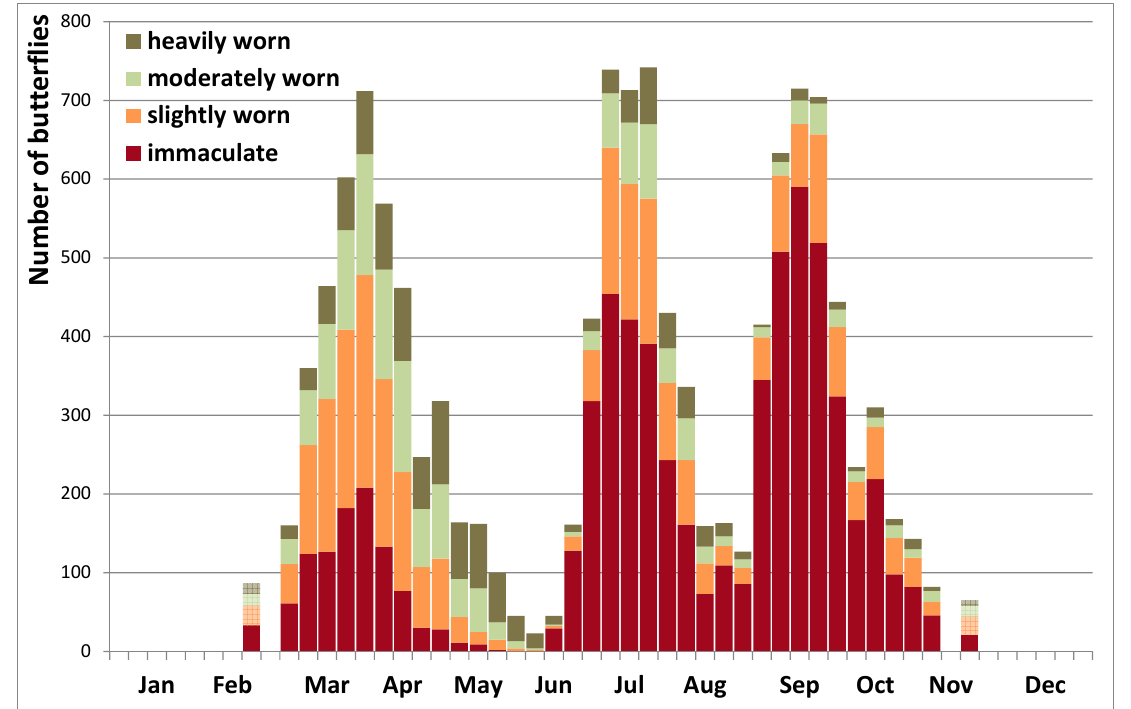
Figure 3. Phenology of wing wear of peacock butterflies in Belgium 2009–2020: numbers by week ( n = 12,425). (The lower numbers before week 10 and after week 44 were lumped and plotted at weeks 8 and 46).